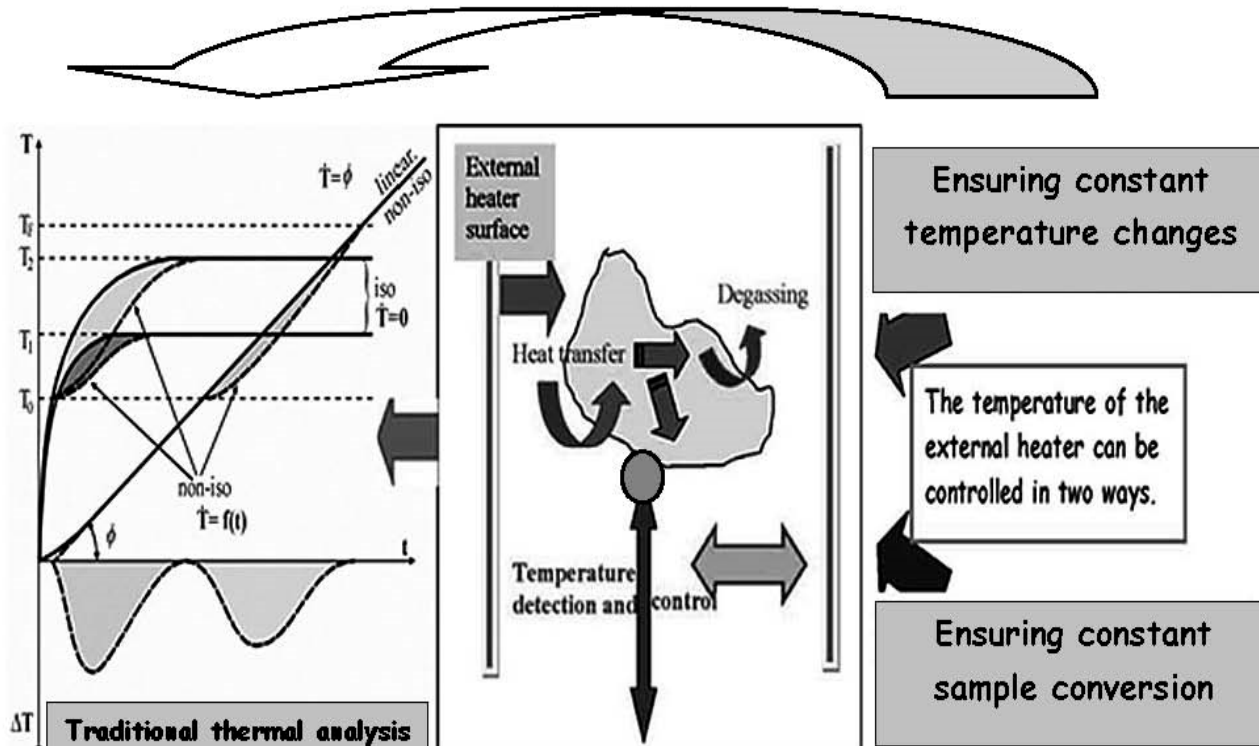
Figure 1. Schematic view of any (thermo-analytically) placed sample studied inside a heated furnace showing possible internal and external flows which thus forms the basis of the methodology of thermal analysis studying heat processes (middle). According to the method of the given measurement, i.e., detection of the measured quantity, we can distinguish two types of thermal analysis. In the classical design, the furnace temperature is regulated and the degree of sample conversion is measured, while in the second less common mode, the sample conversion is kept constant by changing the ambient temperature, which is also measured as the